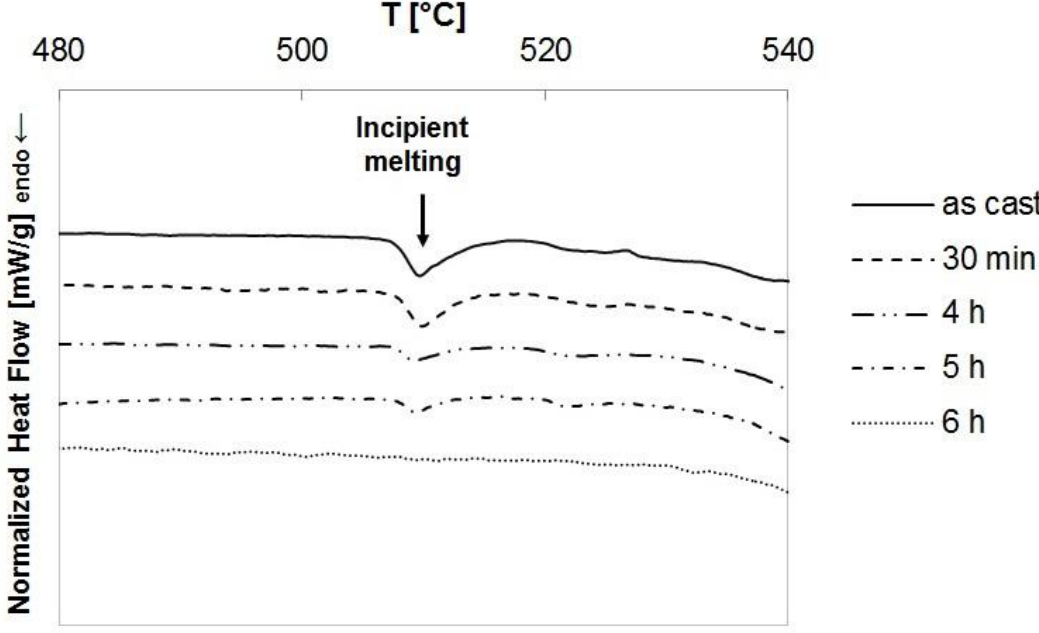
Figure 4. Differential thermal analyses (DTA) carried out on A354 samples solution treated at 495 ◦ C for 30 min, 4, 5, and 6 h (from room temperature to 700 ◦ C in Ar gas, heating rate 10 ◦ C/min), which shows the dissolution of the low melting phase after 6 h. This was readapted from Reference [21].